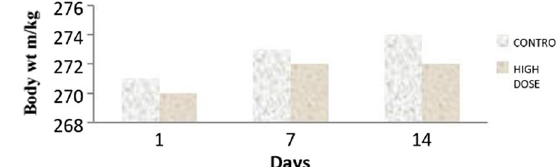
Fig. 2 Change in body weight (mg/kg) of the animals exposed to TRV